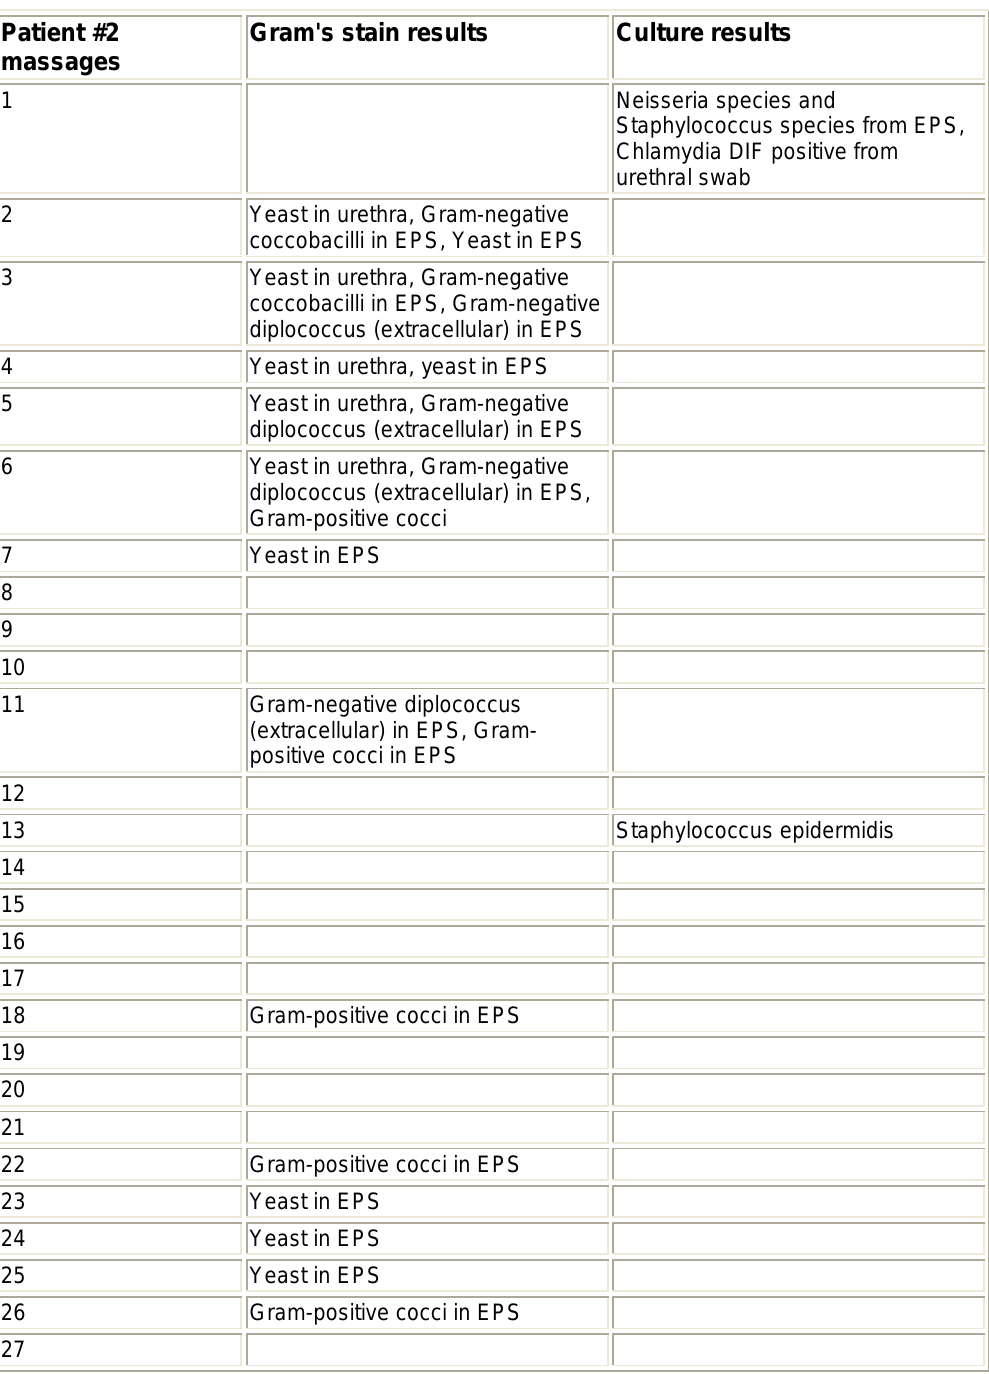
Results of Gram stains and cultures for patient